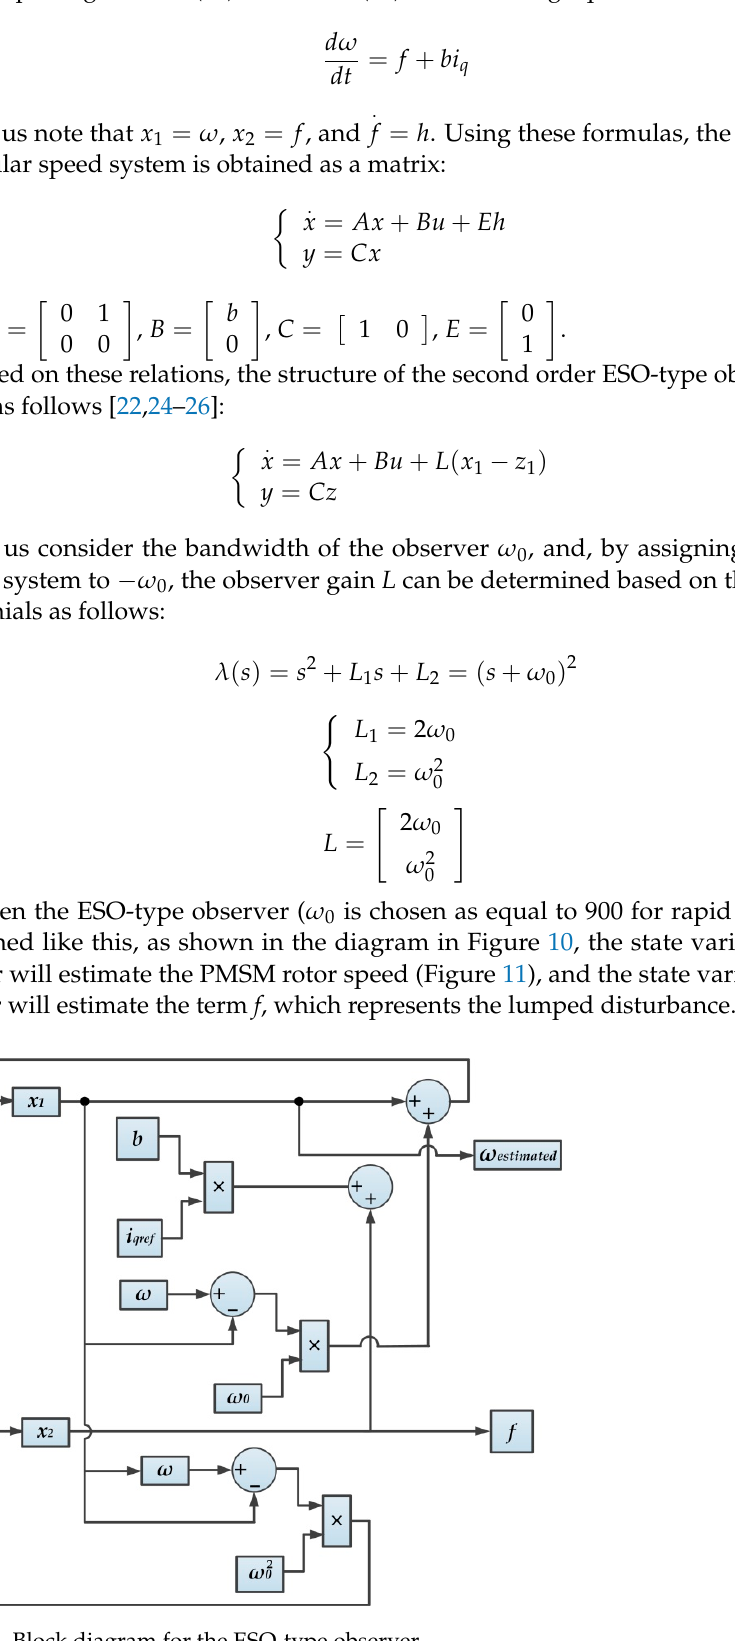
Figure 11. Time evolution of the PMSM rotor speed estimation.